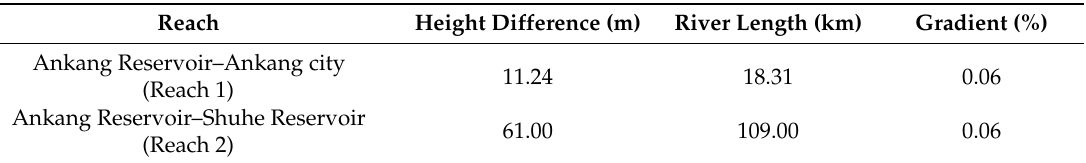
Figure 1. Map of the Hanjiang River and the location of major reservoirs. Table 1. Data of river section.